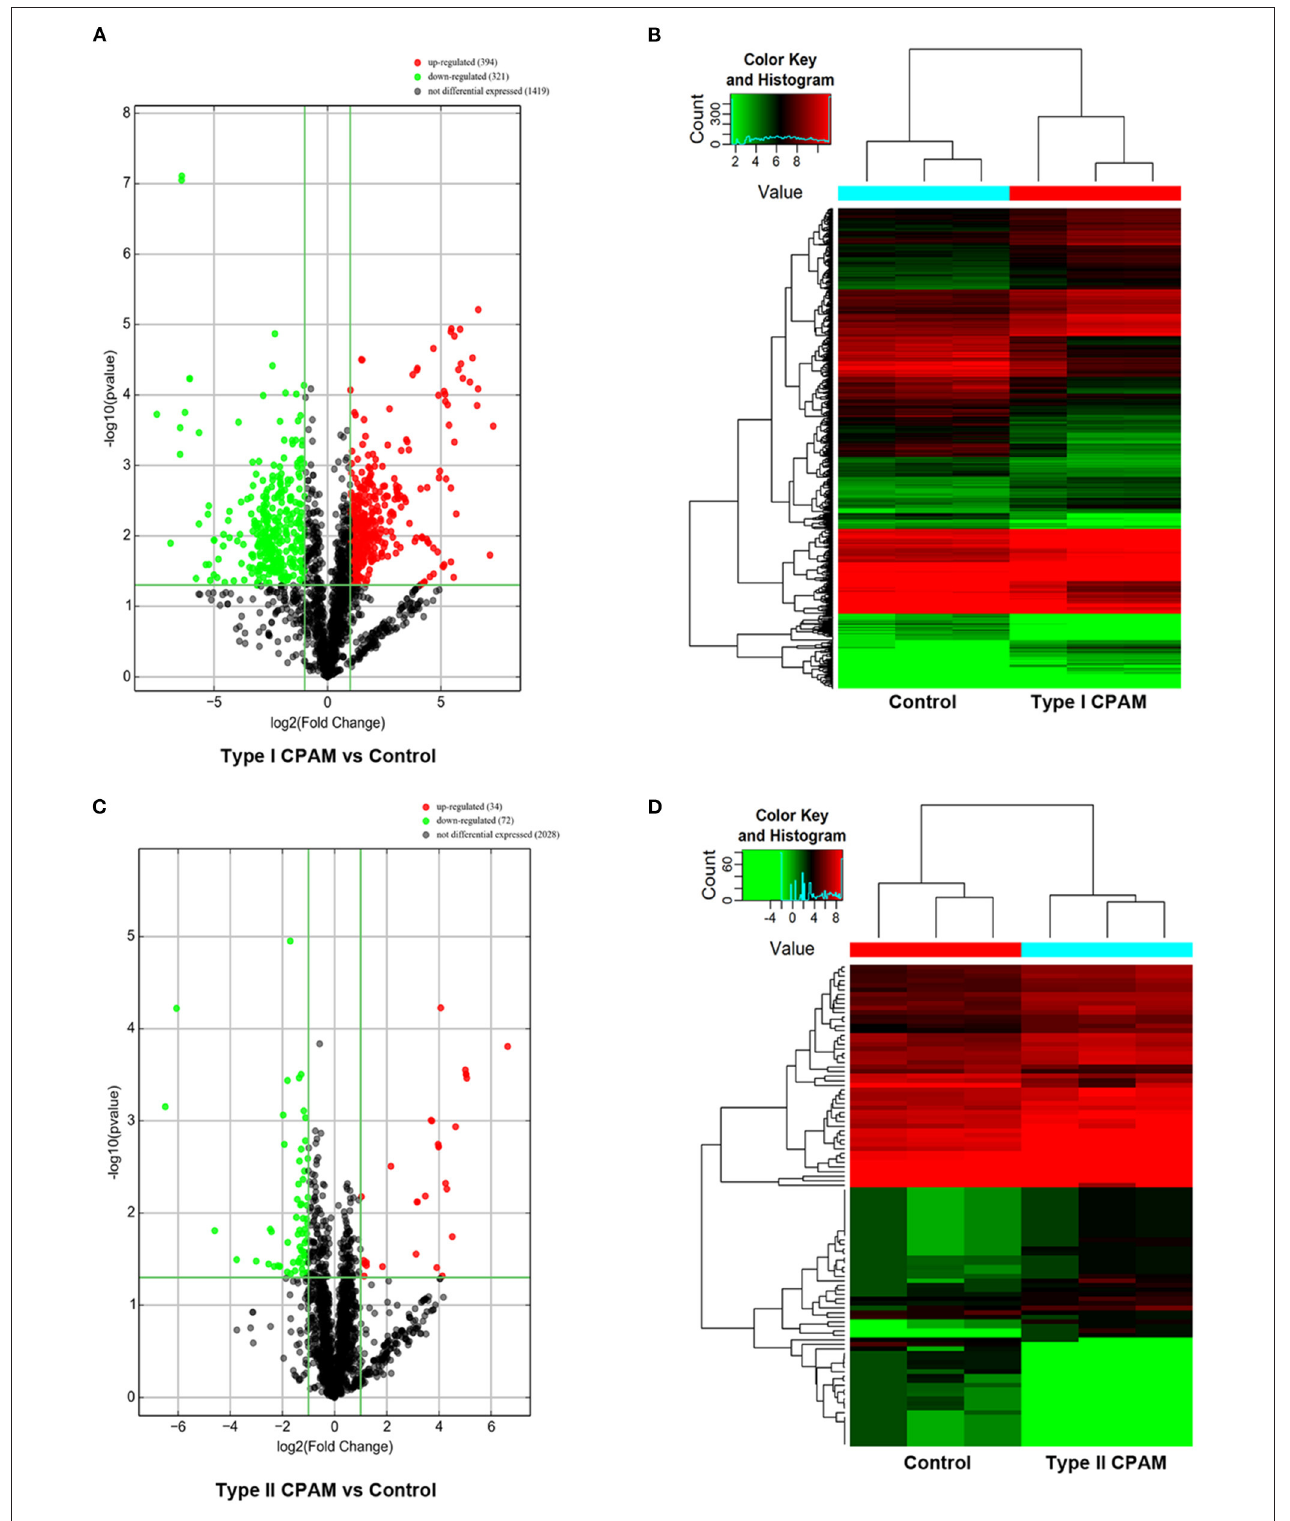
FIGURE 2 | Differentially expressed miRNAs with statistical significance between type I, type II CPAM, and control groups. (A,B) Volcano plot of differentially expressed miRNAs between type I CPAM or type II CPAM groups and control group, (C,D) hierarchical clustering of the differentially expressed miRNAs between type I CPAM or type II CPAM groups and control group. The differentially expressed miRNAs were identified through fold change filtering ≥ 1.0 and false discovery rate ≤ 1.0 ( P ≤ 0.05). Hierarchical clustering was performed using the R scripts.